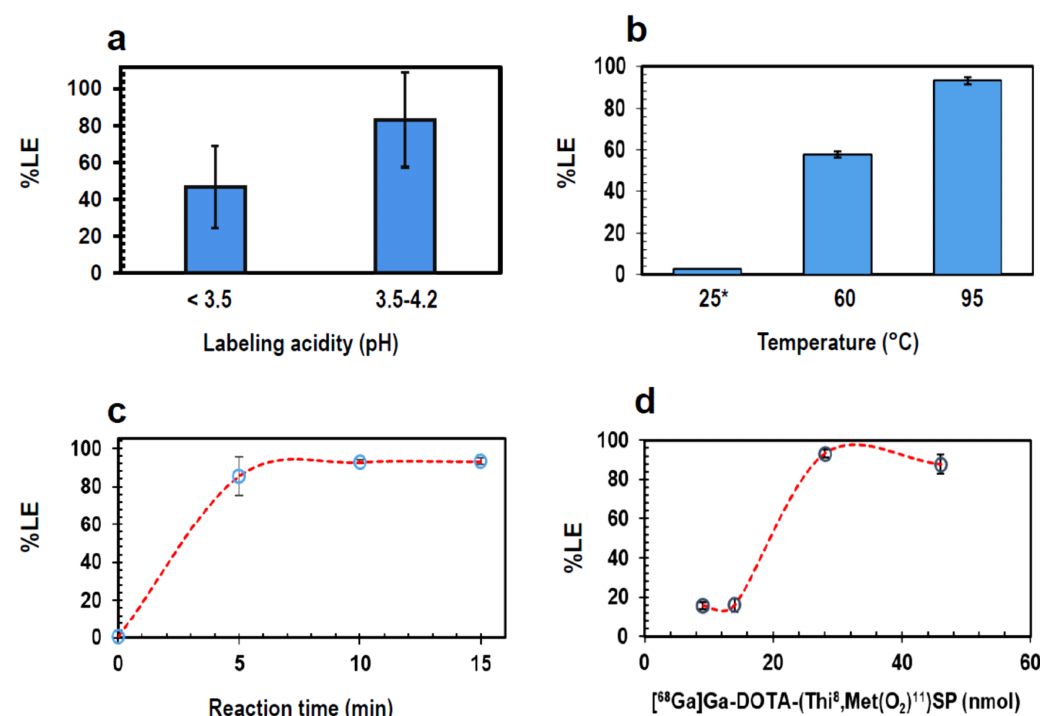
Figure 3. Percentage labeling efficiency of manual radiolabeling of [ 68 Ga]Ga-DOTA-[Thi 8 , Met(O 2 ) 11 ]SP tested against the following parameters: ( a ) pH range, ( b ) incubation temperature, ( c ) incubation time, and ( d ) molarity of DOTA-[Thi 8 , Met(O 2 ) 11 ]SP (nmol). * No radiolabeled product was present at room temperature after 15 min. The solutions were re-analysed 180 min later and there was ~3% radiolabelled product. If not varied otherwise relevant to ( a – d ), the other labeling parameters were as follows: 28 nmol DOTA-[Thi 8 , Met(O 2 ) 11 ]SP, 15 min incubation at 95 ◦ C, pH 3.5–4.0. ITLC: stationary phase—ITLC-SG with mobile phase—0.1 M citrate (pH